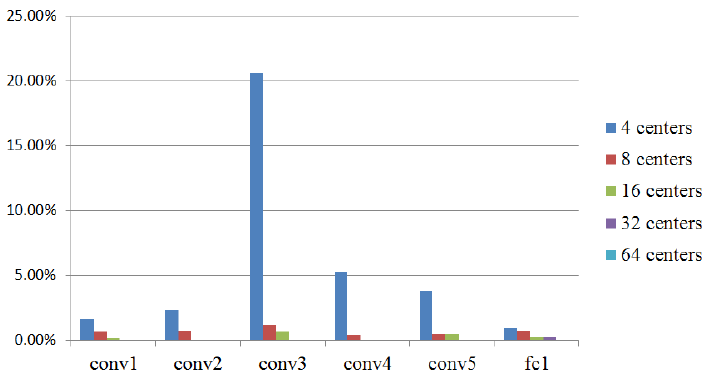
Figure 13. Accuracy loss of different number of centroid in each layer.